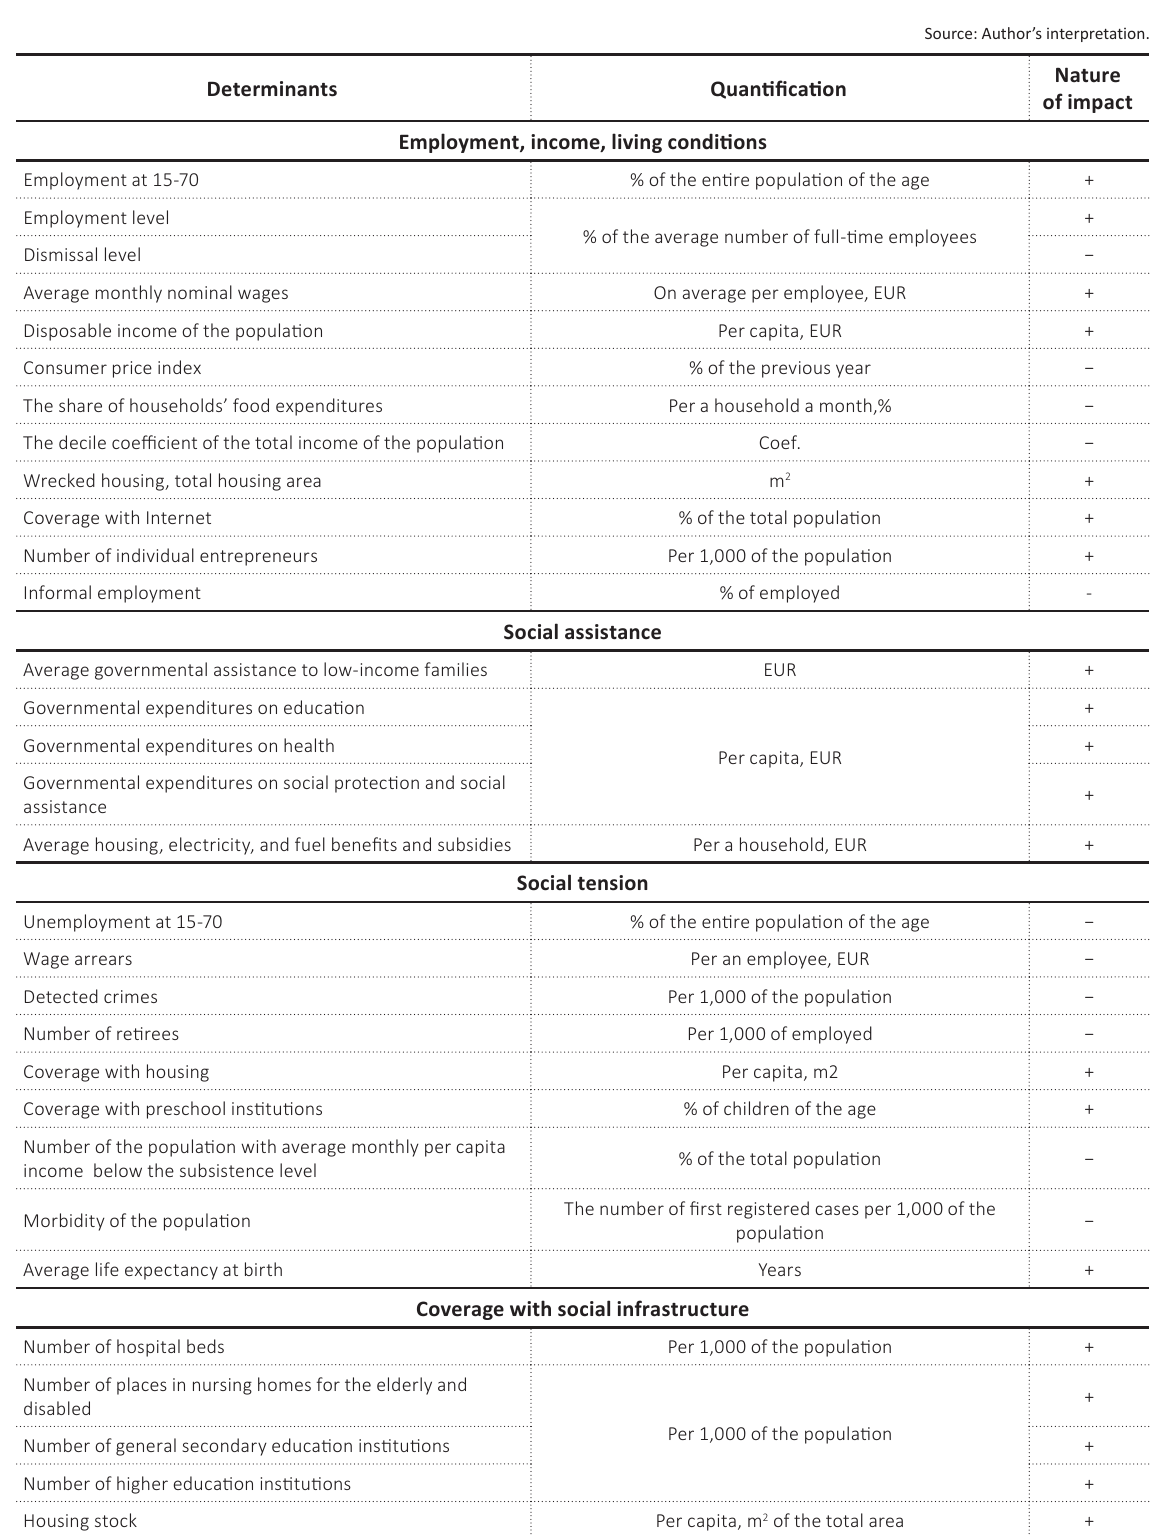
Table A1. The determinants of the population’s social resilience